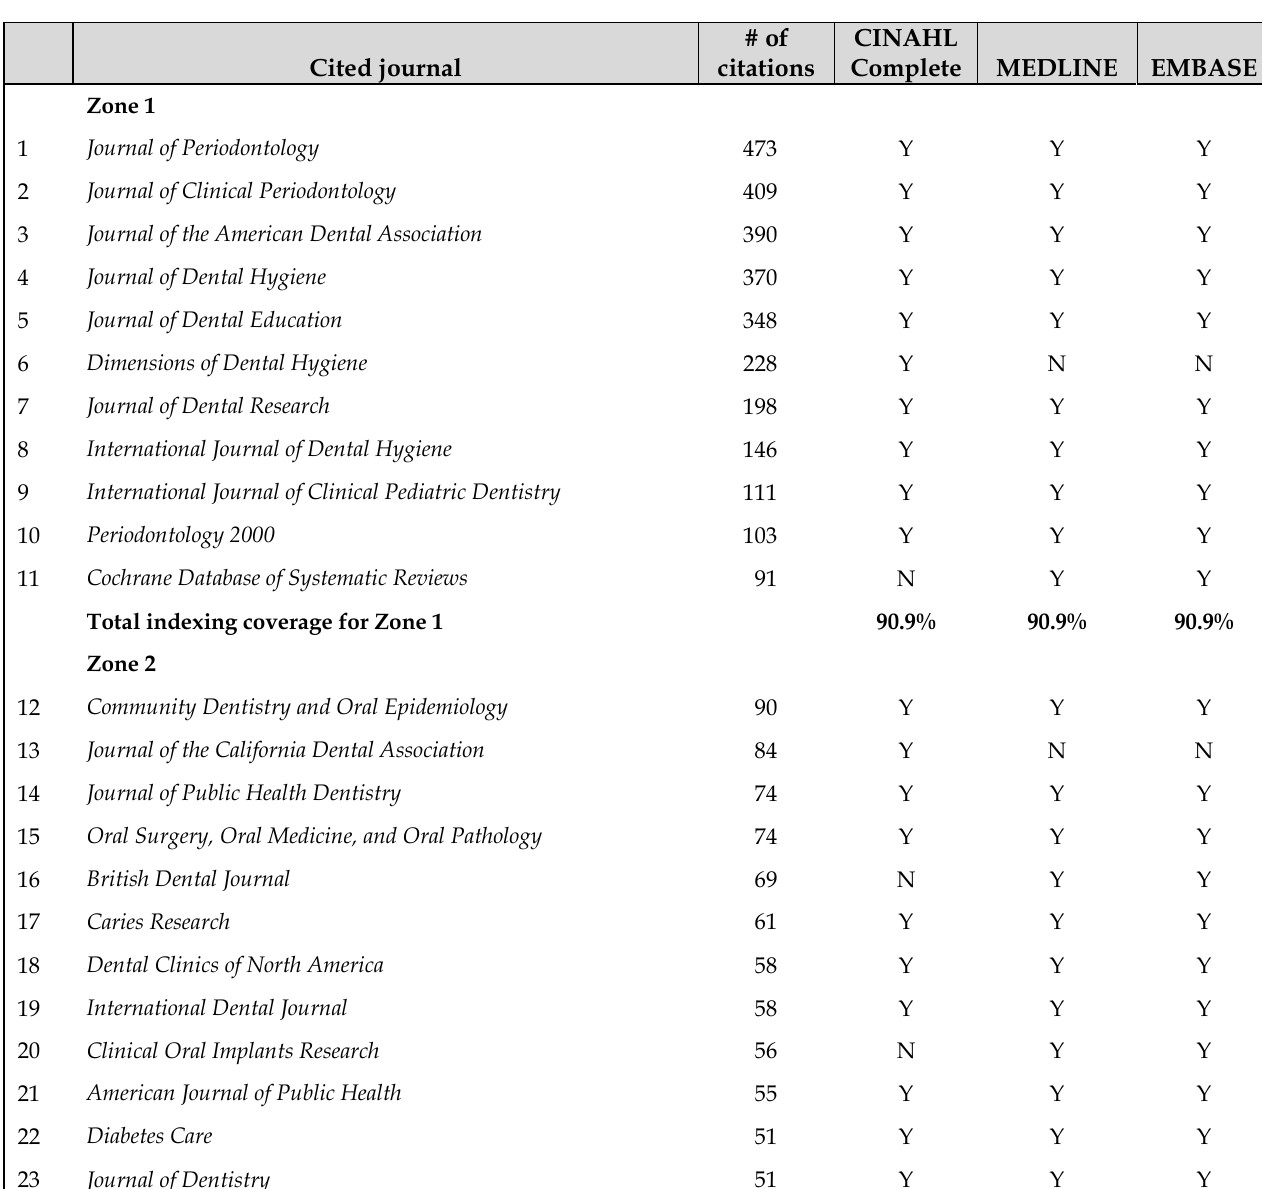
Table 4 Distribution and indexing coverage in of cited journals in Zone 1 and Zone